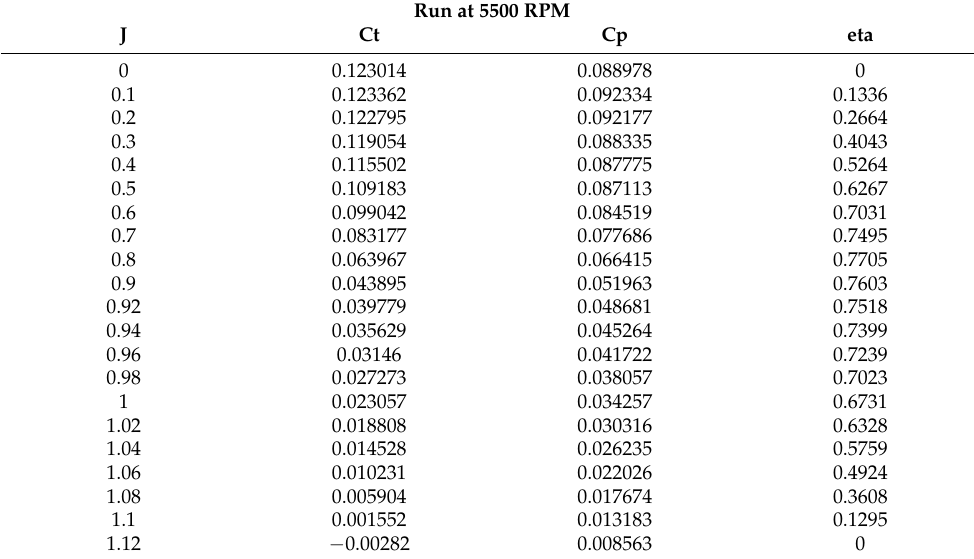
Table A18. BEMT 14 × 12 APC propeller data.